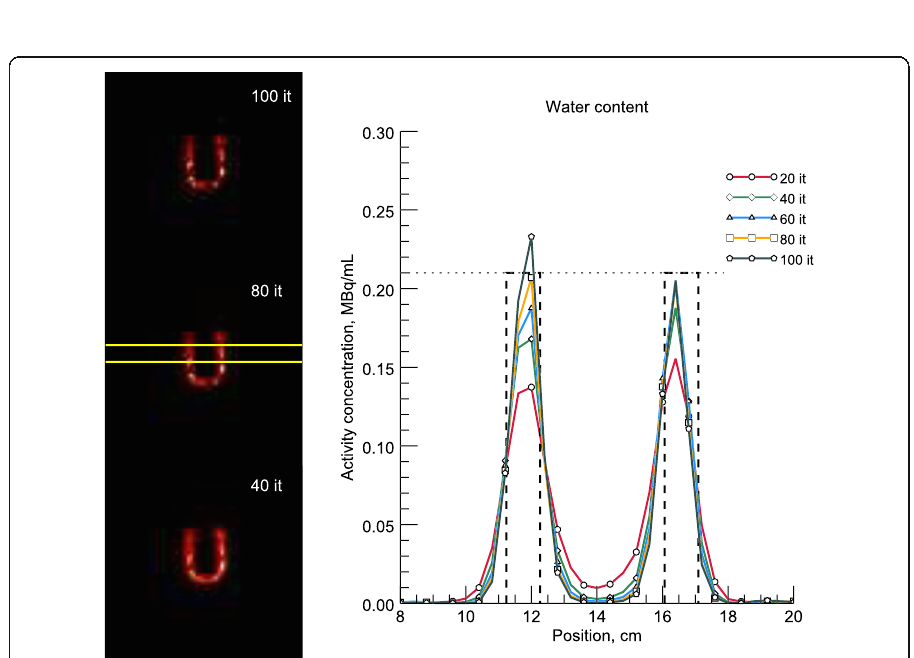
Fig. 9 Line profiles over a reconstructed myocardium with the myocardiac insert in a water-filled torso. On the left are three long-axis images, corresponding to 40, 80, and 100 iterations. The summed profile was calculated from the seven rows in between the yellow markings and includes the data for every 20th iteration. Only alternate data points are marked for clarity. The reference activity concentration, shown by a horizontal dotted line, in the myocardium at the start of the measurement was 0.21 MBq/mL